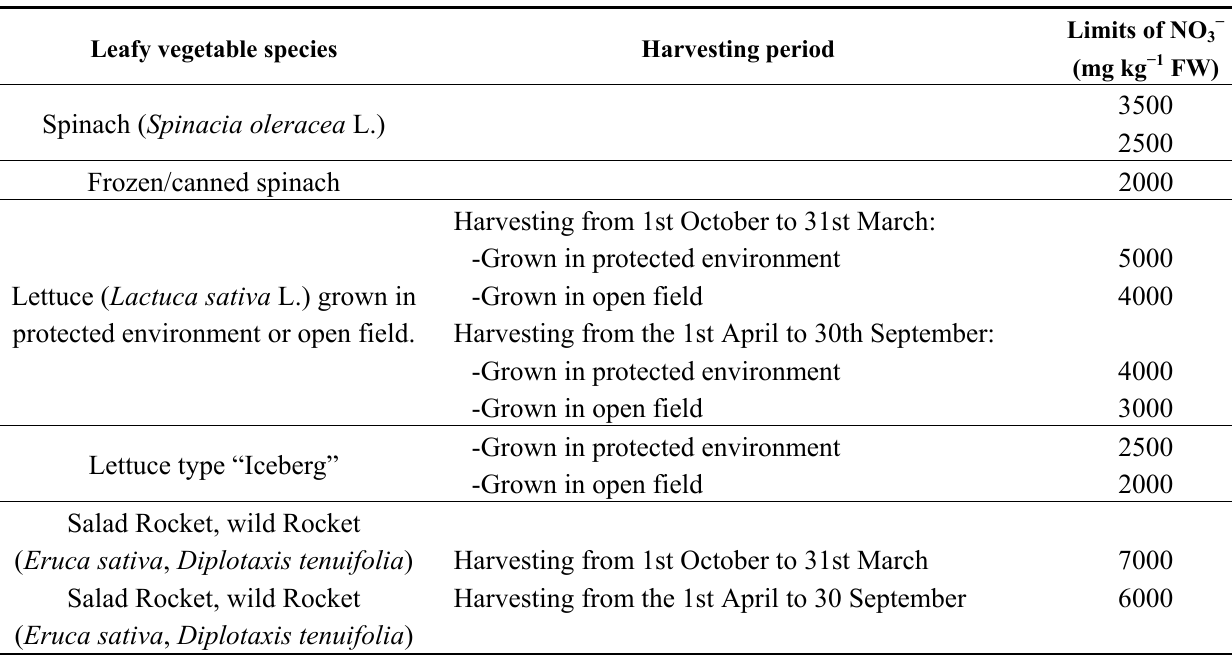
Table 2. Thresholds of nitrates for the commercialization of three leafy vegetables based on European regulation 1258/2011 [89]. Leafy vegetable species Spinach ( Spinacia oleracea